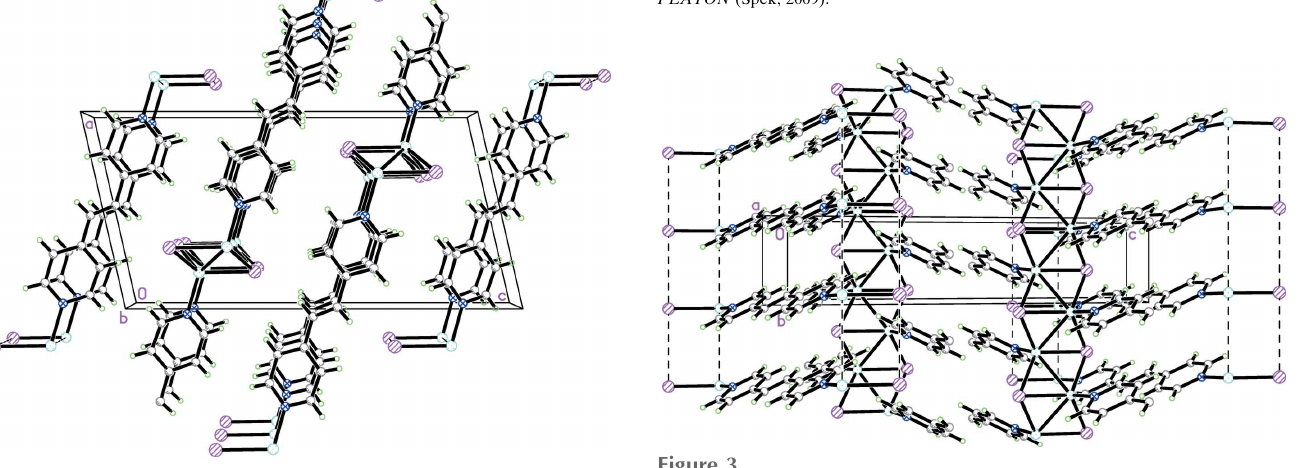
Figure 2 Fragment of the crystal packing along the b -axis direction.